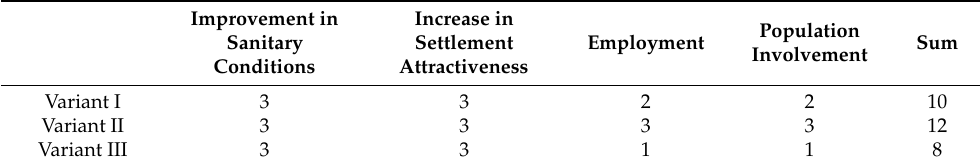
Table 6. Results of centralized sewage management social sustainability assessment, 3 points—the best option, 1 point—the weakest option.